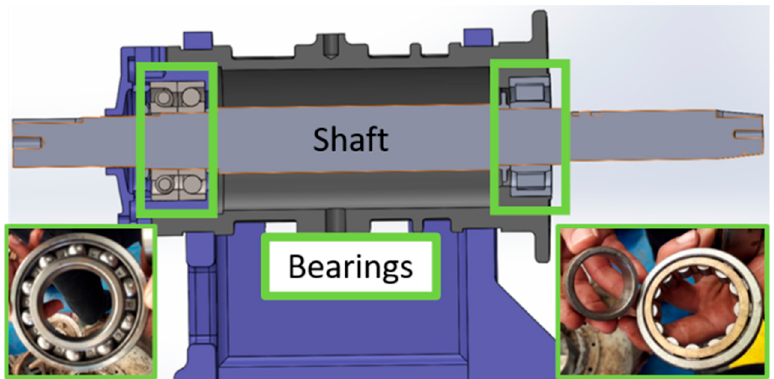
Figure 6. CAD diagram and photos of parts that are bought overseas.